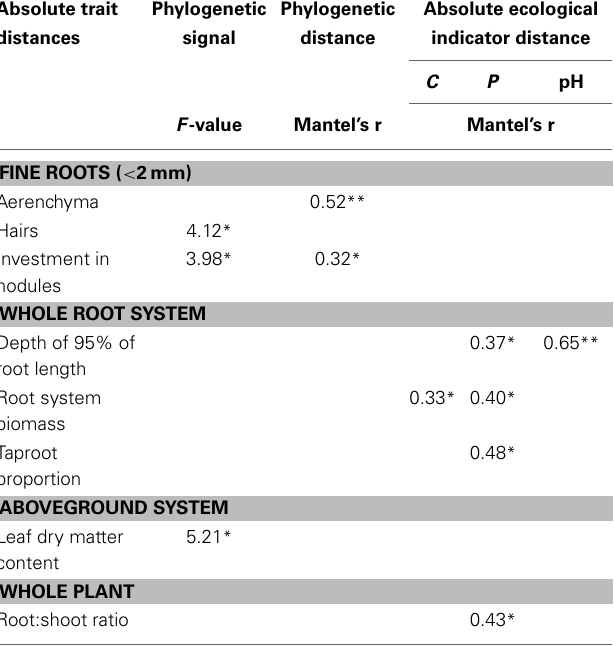
Table 3 | Results of variance analysis of the phylogenetic signal among functional traits and results of the Mantel test ( r- and p -values) between pair-wise species absolute trait distances and phylogenetic distance and absolute ecological indicator